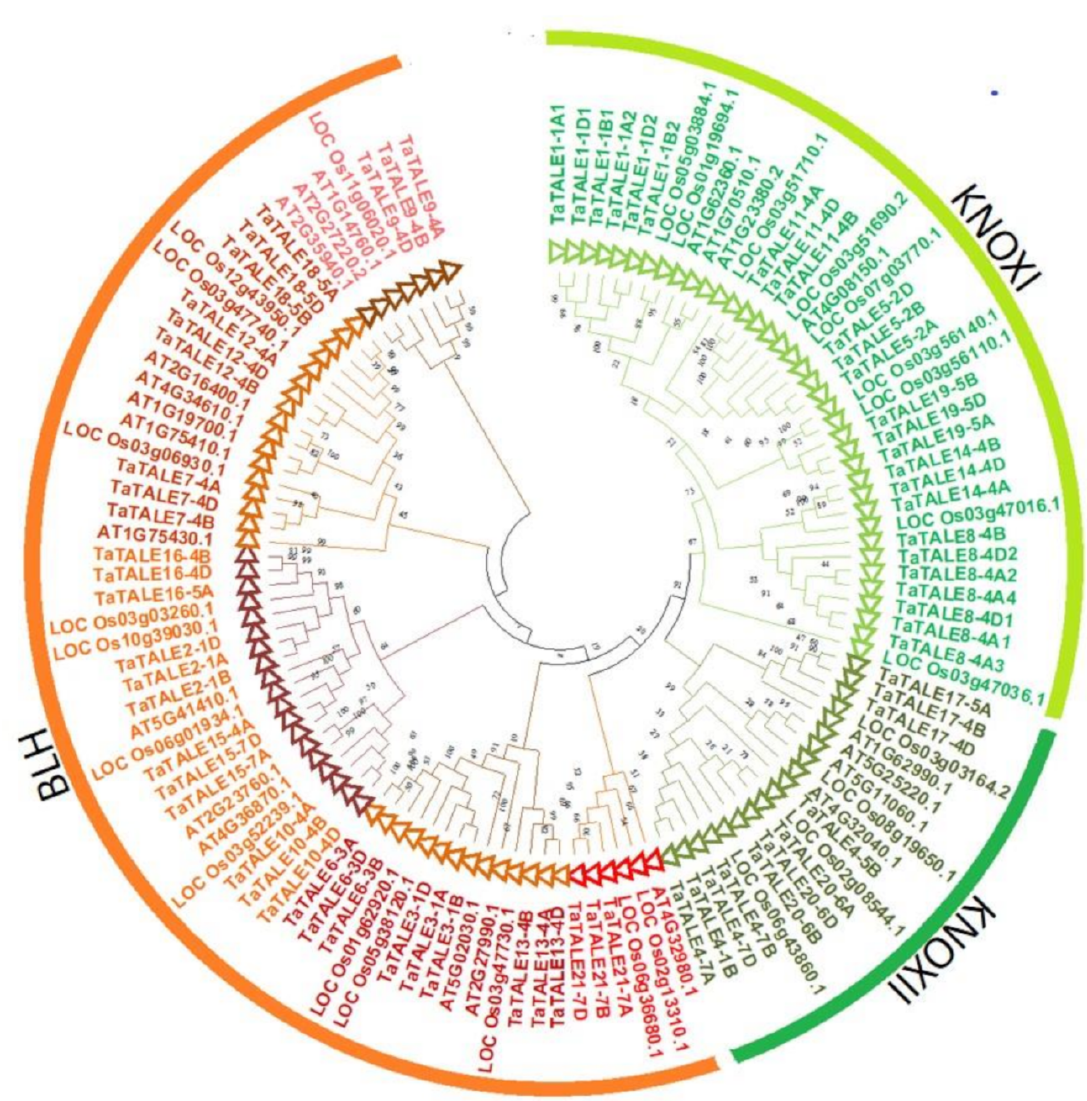
Figure 2. Phylogenetic analysis of the TALE proteins of Arabidopsis, rice, and bread wheat. The full- length protein sequences were used for the construction of a phylogenetic tree using the MEGAX. The tree shows two major groups, BLH and KNOX, which are further divided into subclasses highlighted with different